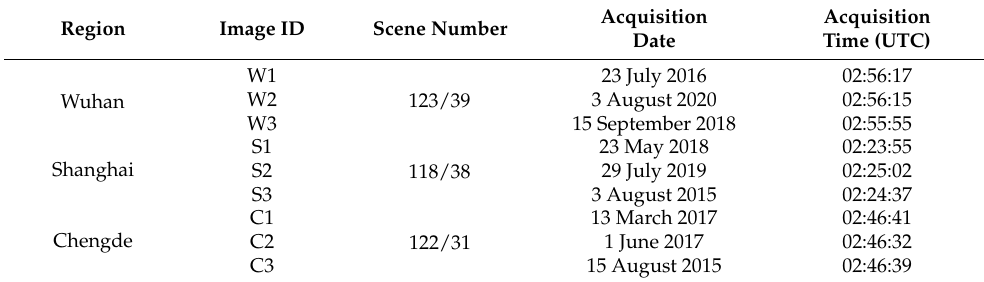
Table 1. Information of the selected Landsat 8